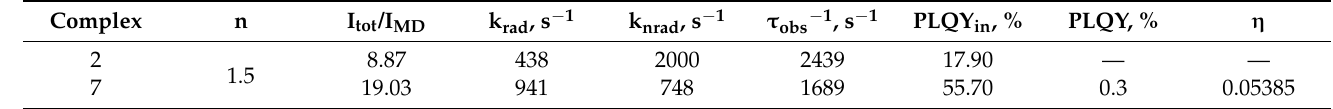
Table 6. Photophysical parameters for complexes 2 and 7 in the solid state. Internal quantum yields Φ η . in and sensitization coefficients